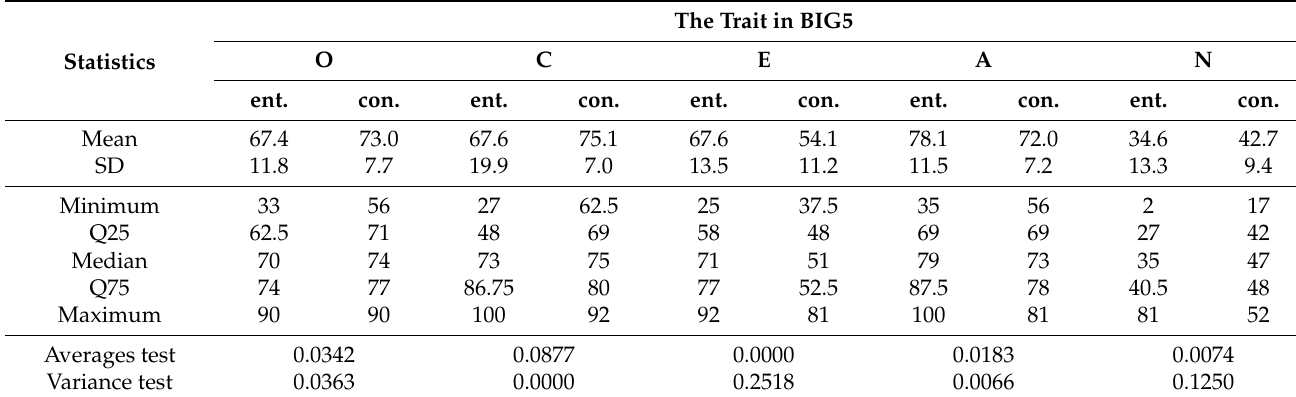
Table 2. Statistics of the OCEAN personality model